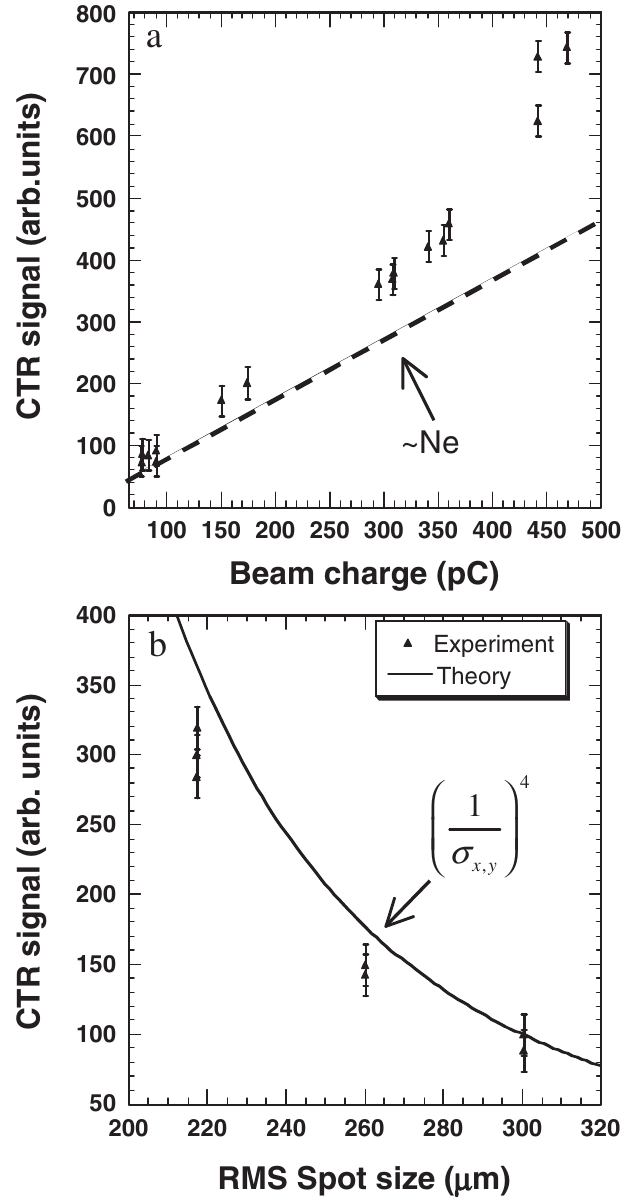
FIG. 4. Fundamental 10 - (cid:1) m CTR signal as a function of electron beam charge (a) and the transverse spot size (cid:5) x;y on the CTR screen at a fixed charge of 300 pC (b).